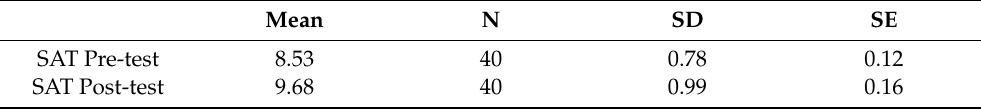
Table 8. Paired samples statistics of SAT.